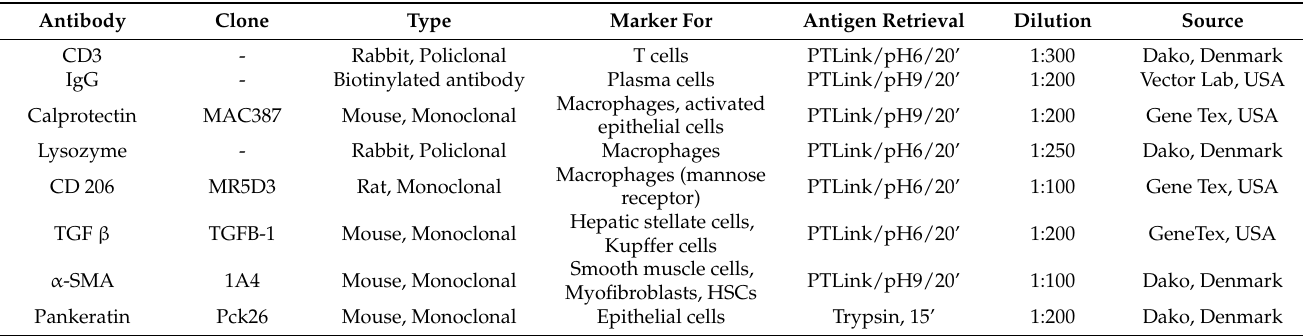
Table 1. Antibodies, specificity and immunohistochemical procedure used.